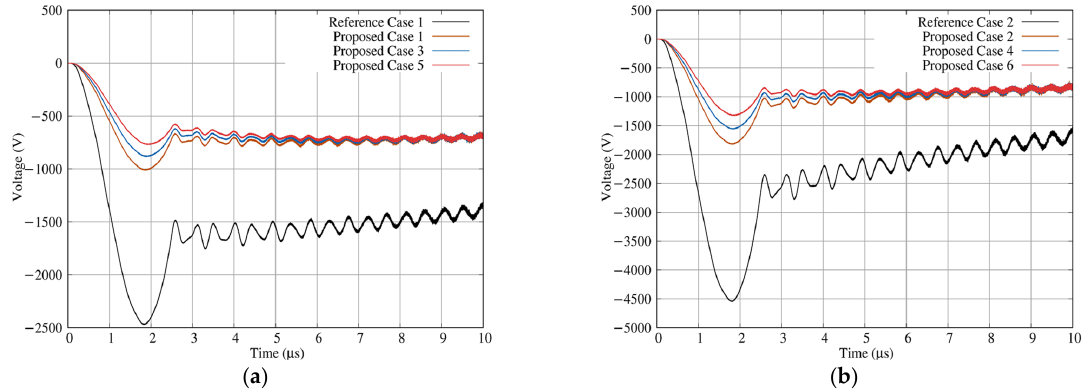
Figure 10. The calculated surge arresters’ currents for ( a ) 𝐼 (cid:3040)(cid:3028)(cid:3051) = 5 kA and ( b ) 𝐼 (cid:3040)(cid:3028)(cid:3051) = 10 kA .